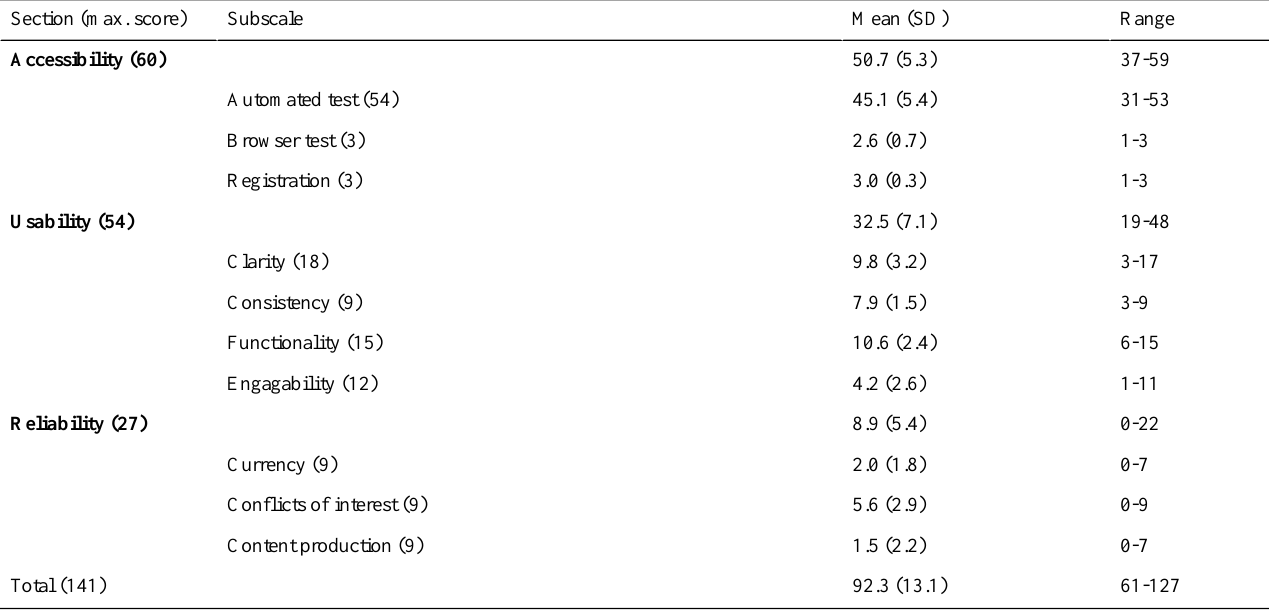
Table 3. Means, standard deviations, and ranges of the included websites measured by the LIDA tool (the maximum achievable scores in shown in brackets after each section and question).